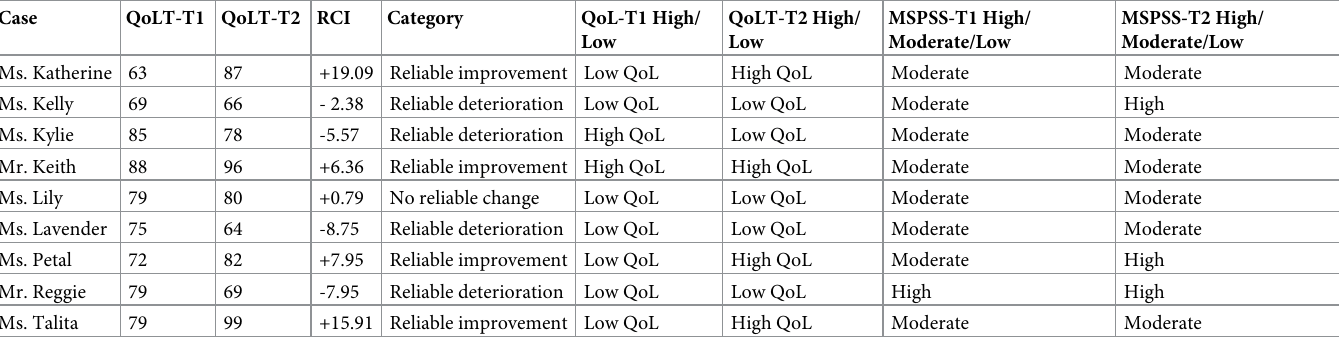
Table 2. RCI’s for quality of life total scores ( N = 9).